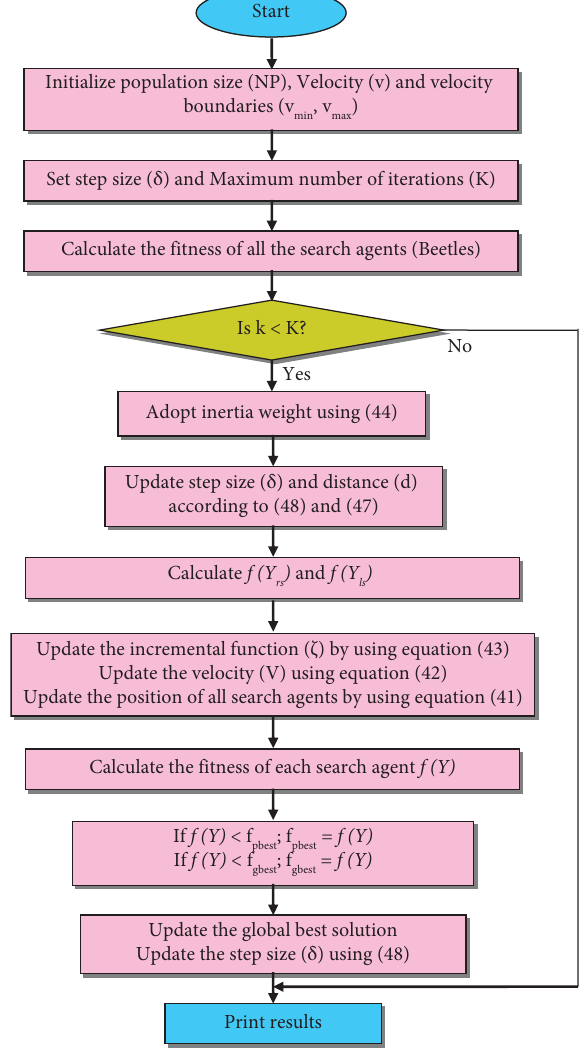
Figure 3: Flowchart of the proposed BSOA for the OPF